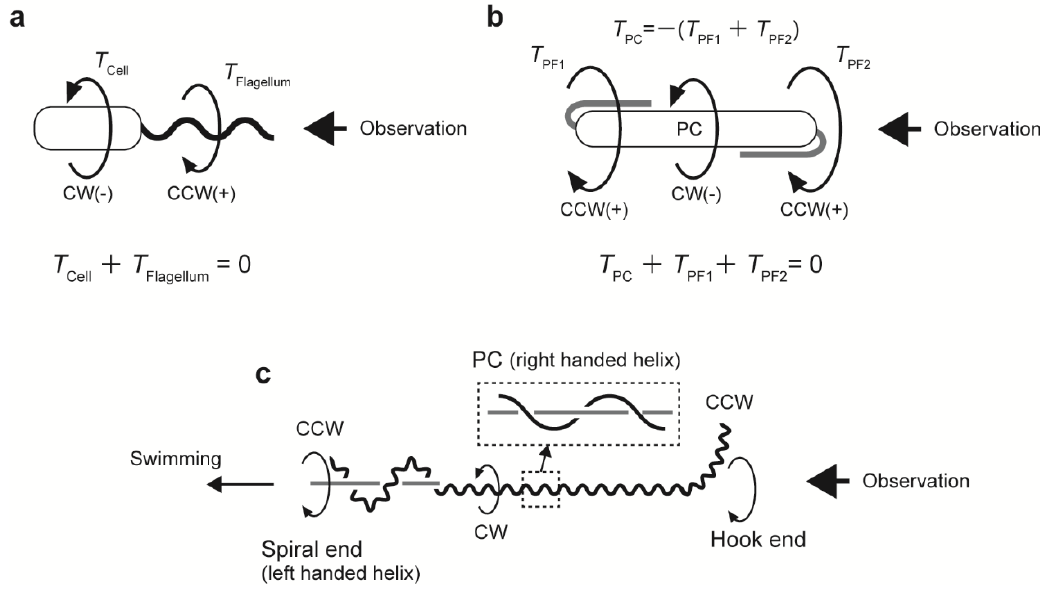
Figure 2. Mechanical models for bacterial swimming. ( a ) Steady-state swimming of an externally flagellated bacterium. Torques of the cell body ( T Cell ) and flagellum ( T Flagellum ) are balanced, that is, their sum is zero. ( b ) Schematic of spirochetal swimming, where the outer membrane is ignored. The protoplasmic cylinder (PC) is rotated by the counter torque of the periplasmic flagella (PFs) rotating at both ends of the cell body. ( c ) Swimming model for Leptospira . Rotational directions are indicated by large arrows.